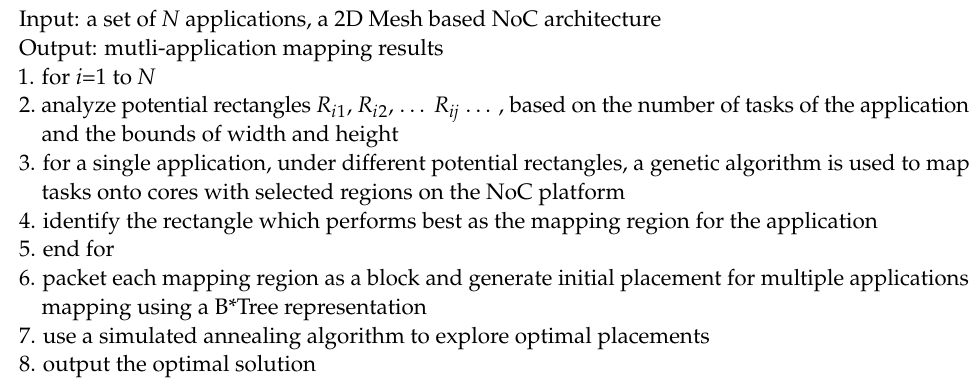
Algorithm 1 The main procedure of the proposed multi-phase multi-application mapping